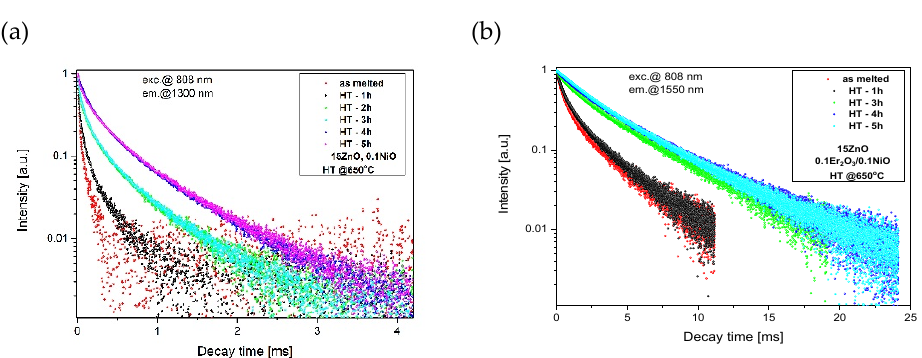
Figure 13. Luminescence decay curves from ( a ) Ni 2+ : 3 T 2 ( 3 F), ( b ) Er 3+ : 4 I 13/2 levels in GGK with 15 ZnO glass and glass-ceramics (HT@650 ° C for 1–5 h), λ exc = 808 nm.